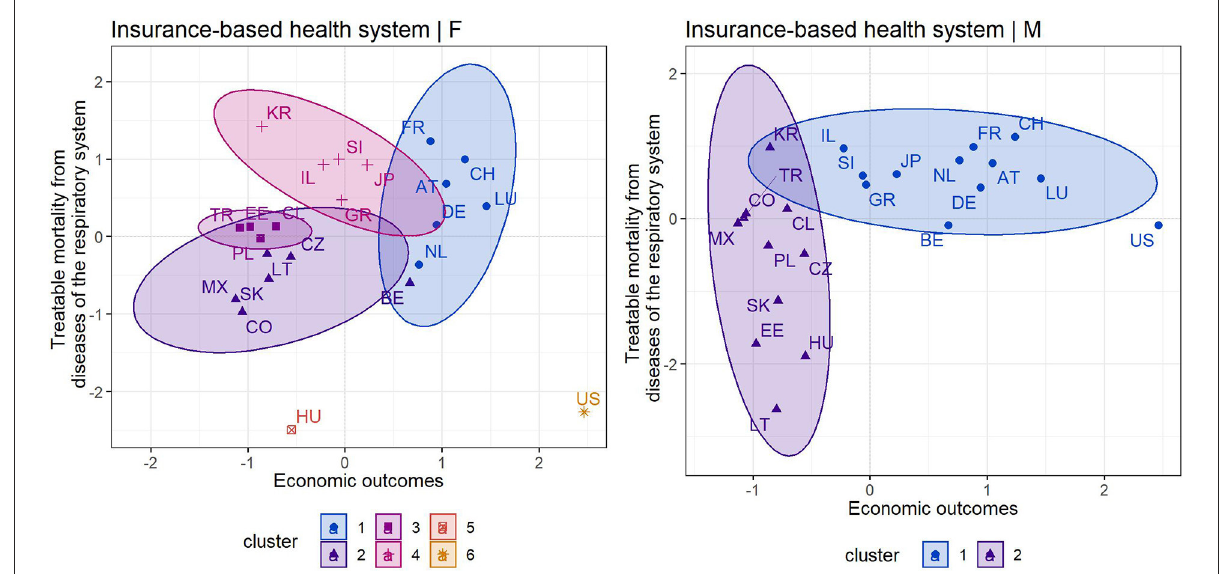
FIGURE2 Cluster maps of countries applying an insurance-based health system [left—female population, right—male population) [Source own processing based on available data